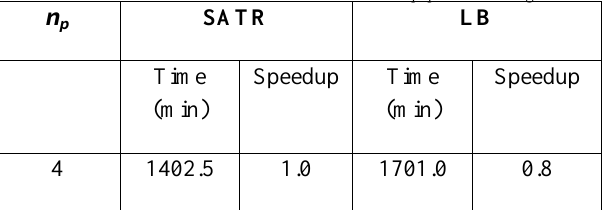
Table 5. Parallel computation for 3 DV, n